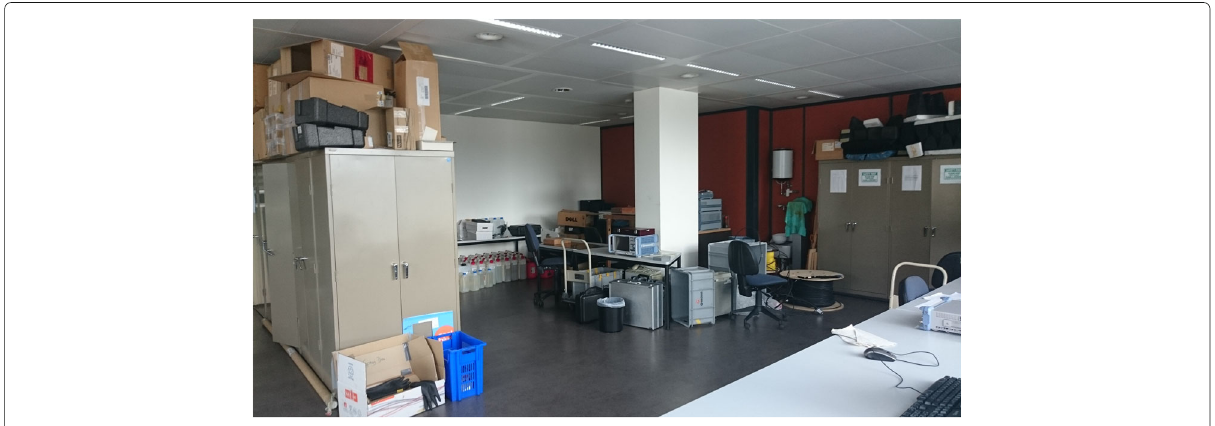
Fig. 12 Measurement environment: photograph of small side